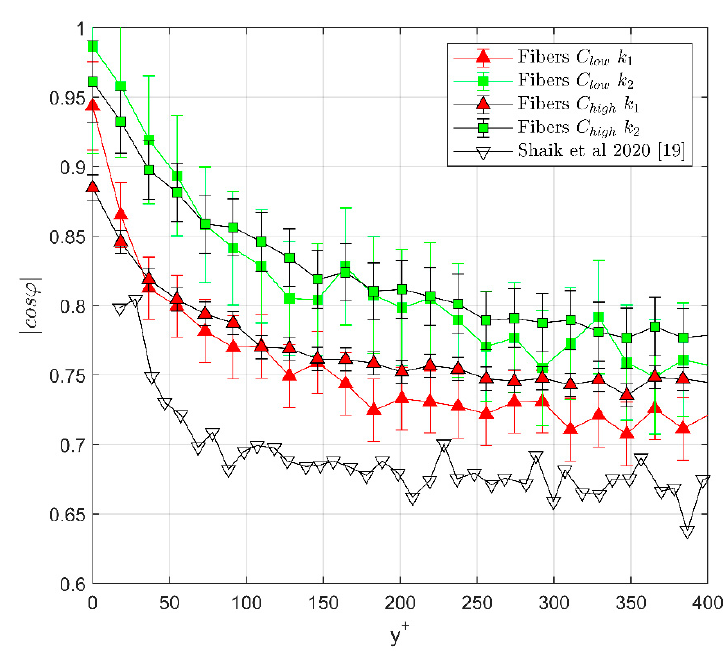
Figure 11. Average of cosine of fiber orientation angle ϕ , compared to experimental data from Shaik et al. (2020) [19]. Error bars indicate a 95% confidence interval based on Student’s t-distribution.